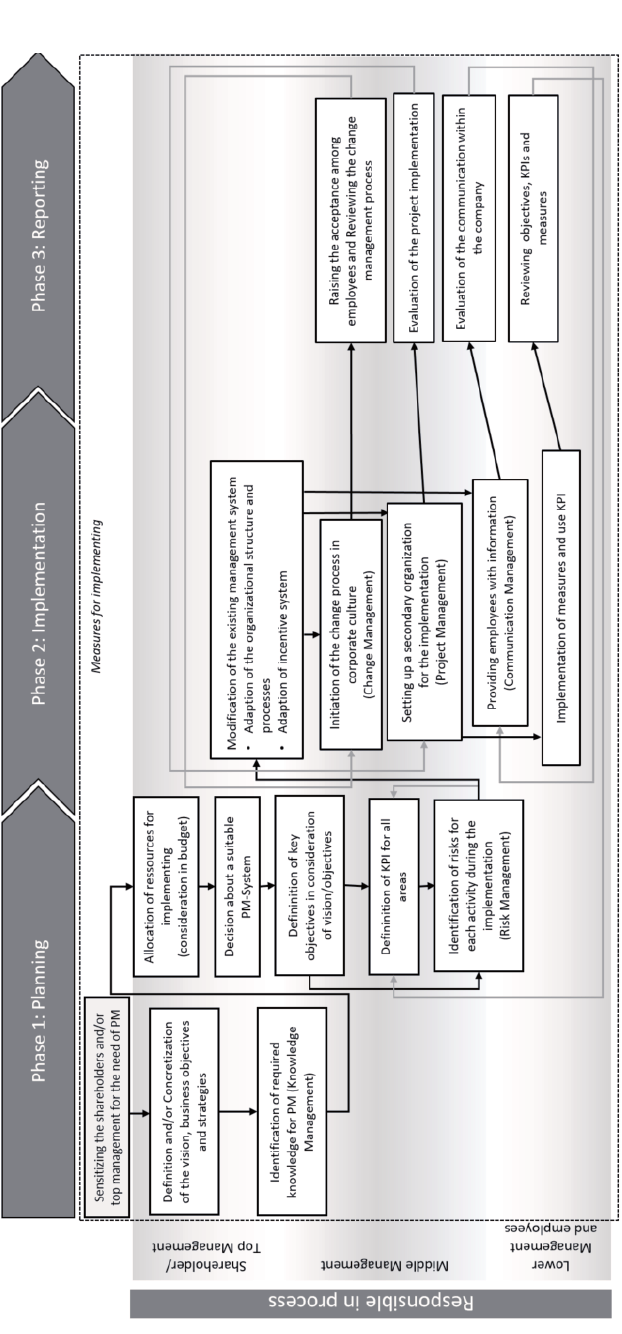
joc2021-1-v4.indd 58 24.3.2021